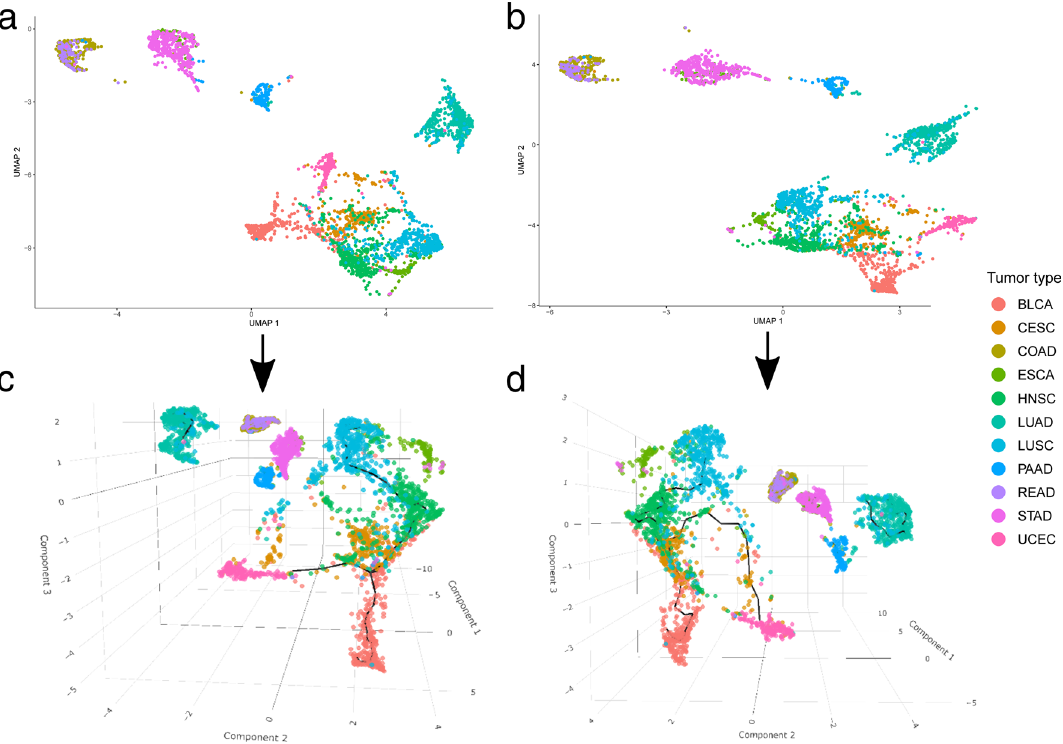
Figure 1. Spatial analysis showing differences between tumors. ( a ) AP-2α target genes list. ( b ) AP-2γ target genes list. ( c ) 3D trajectory of the first subfigure. ( d ) 3D trajectory of the second subfigure. Figure created using Monocle3 (https:// cole- trapn ell- lab. github. io/ monoc